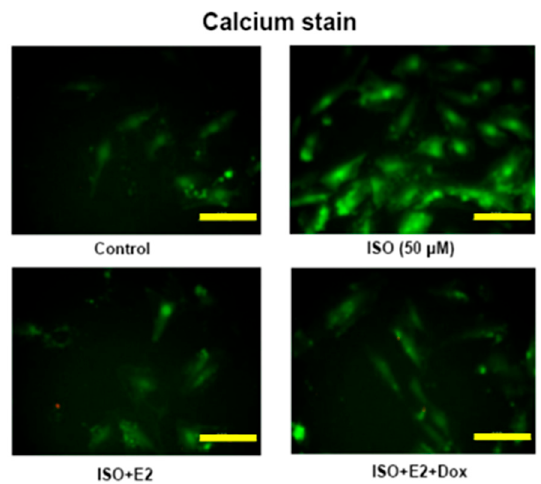
Figure 3. E2/ER β attenuates ISO induced calcium accumulation in H9c2 cells. Tet-on ER β H9c2 cells were incubated with E2 (10 − 8 M), Dox (2 μ g/mL) in the presence of ISO (50 μ M) for 24 h, then fluo-4AM calcium staining was performed. The images were detected by fluorescent microscope (Bar length = 10 μ m).